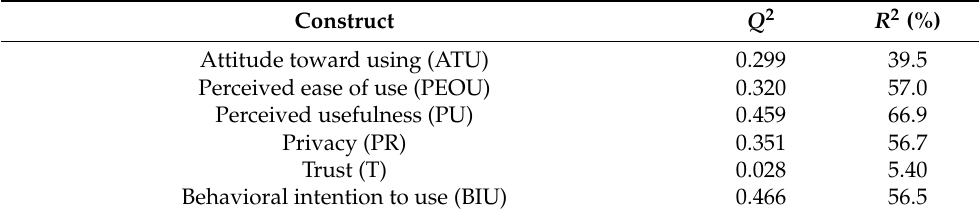
Table 6. Results of R 2 and Q 2